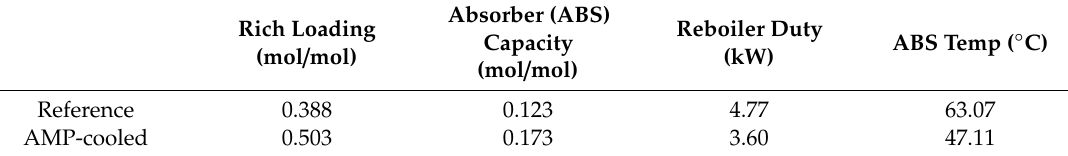
Table 3. Results for intercooling configuration.